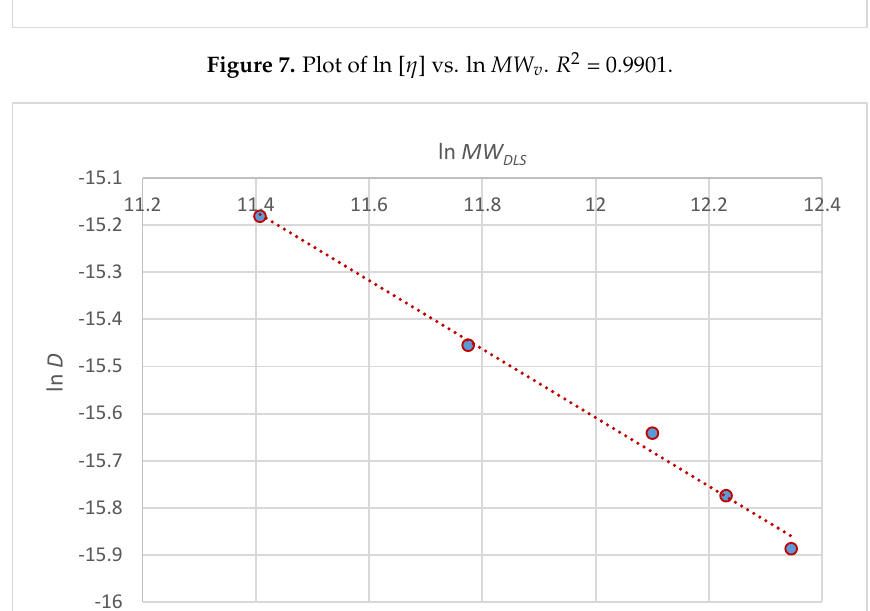
Figure 8. Plot of ln D vs. ln MW DLS . R 2 = 0.9925. Table 3. Data of D , molecular weight (DLS and viscometric), and intrinsic viscosity of hydrolyzed StrG. c